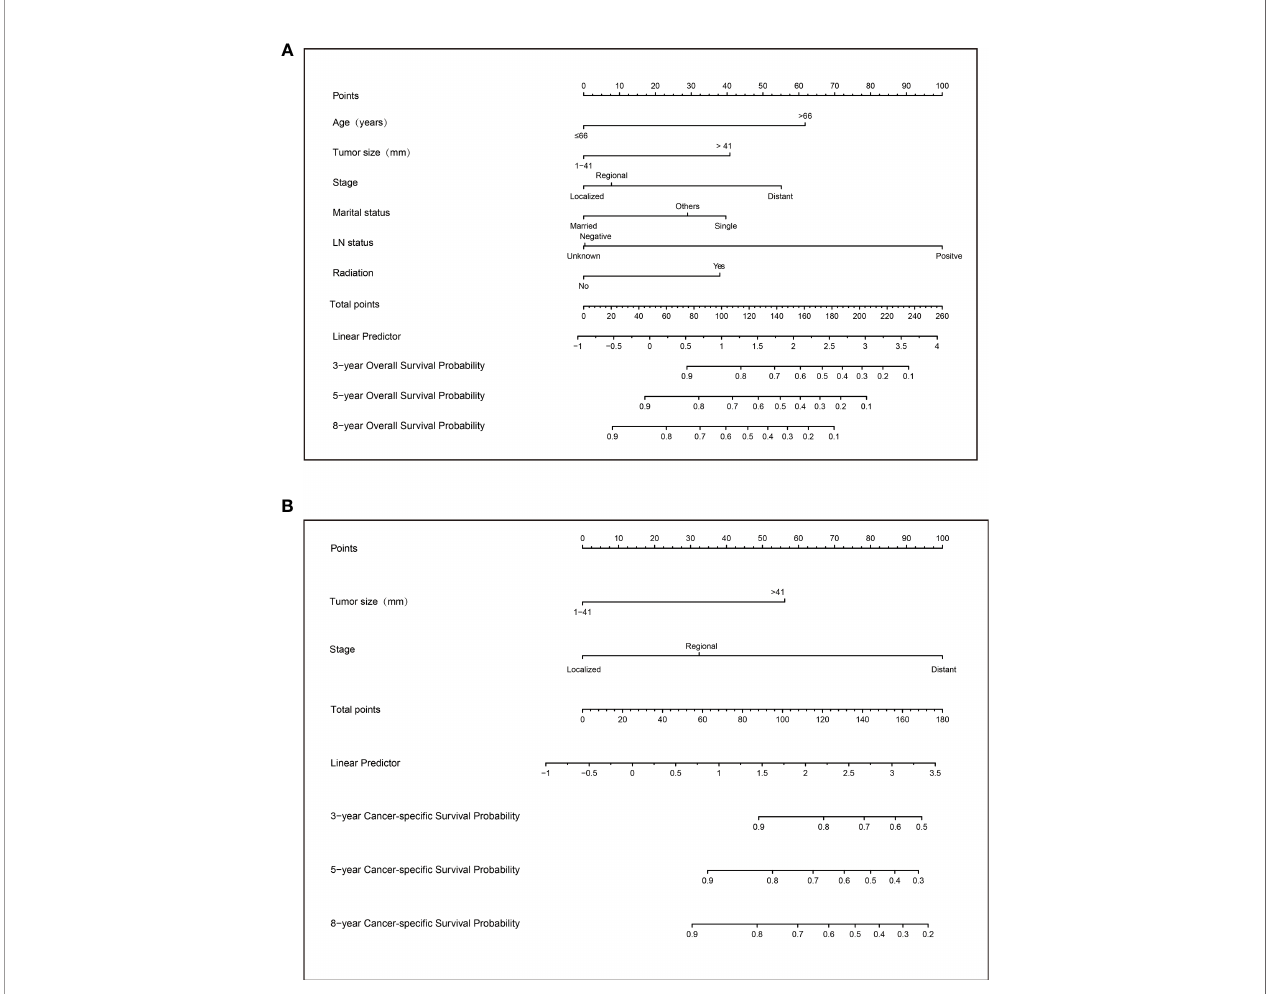
FIGURE 3 | Nomograms to predict 3-, 5-, and 8-year overall survival (A) and cancer-speci fi c survival (B) for patients with parathyroid